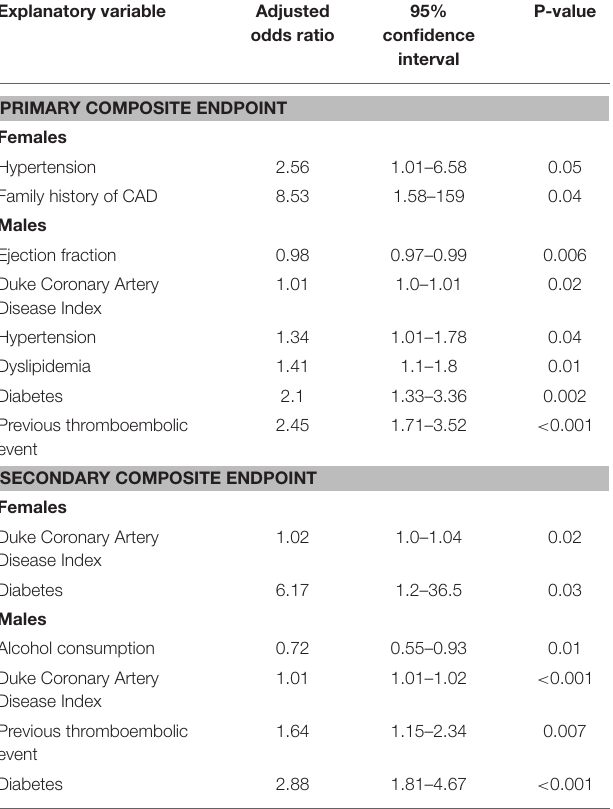
TABLE 4 | Independent predictors of recurrence of primary and secondary composite